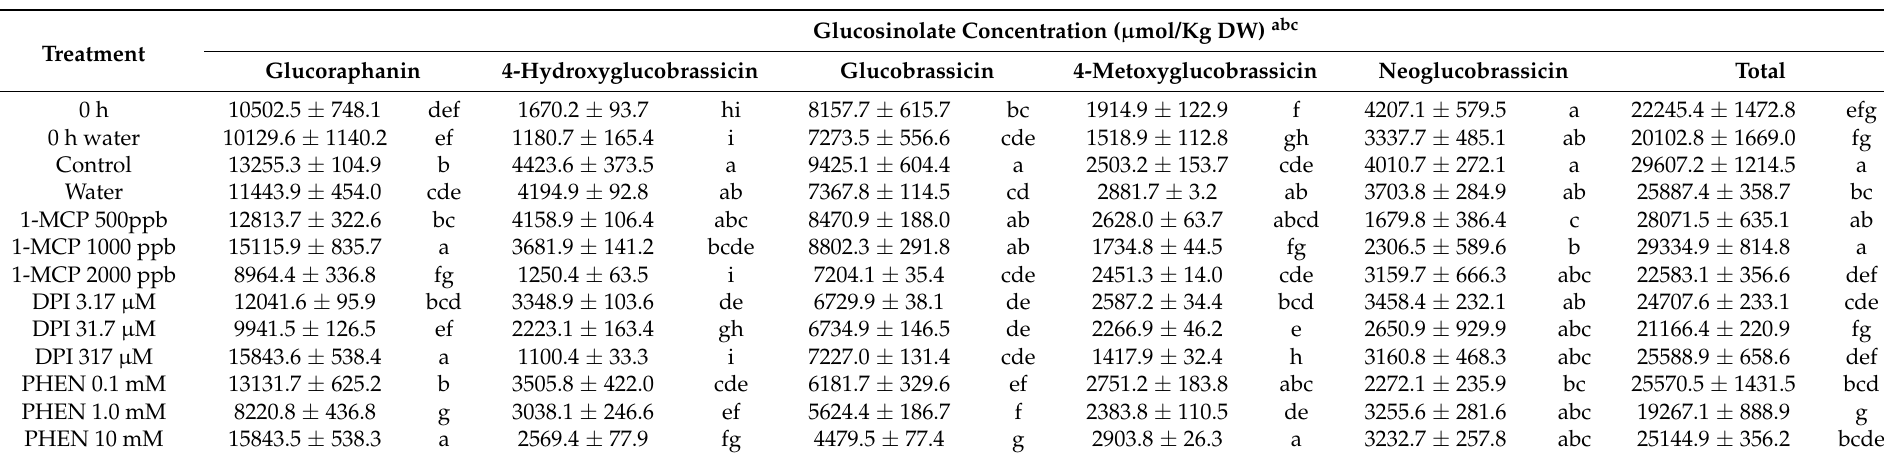
Table 1. Individual glucosinolate concentration in broccoli chops treated with different concentration of signaling molecule inhibitors and stored for 21 h at 20 ◦